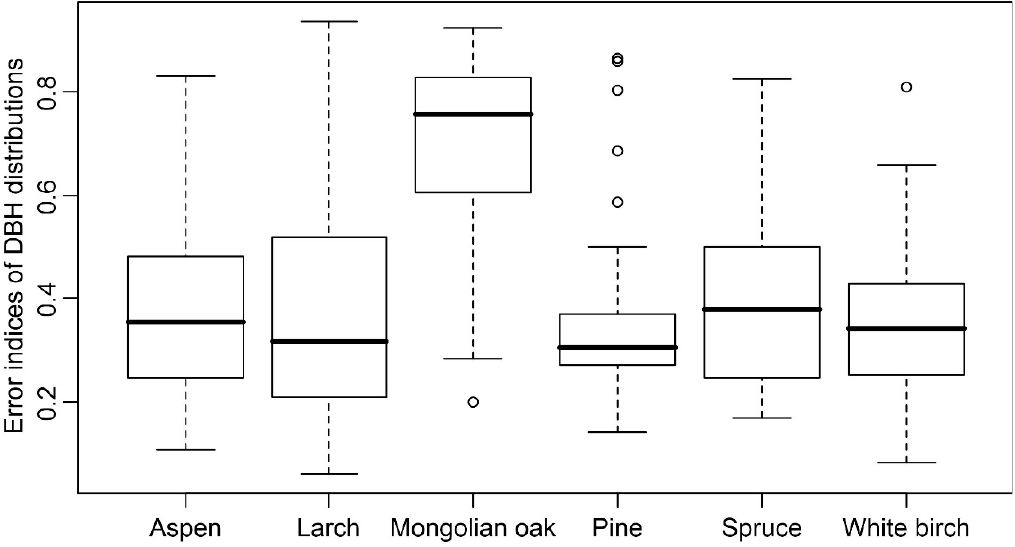
Figure 6. Error indices of estimated wall-to-wall tree-lists by species in 2000 based on the transformed inventory tree-lists data. The error indices were calculated by each transformed plot. Forests 2018 , 9 , x FOR PEER REVIEW